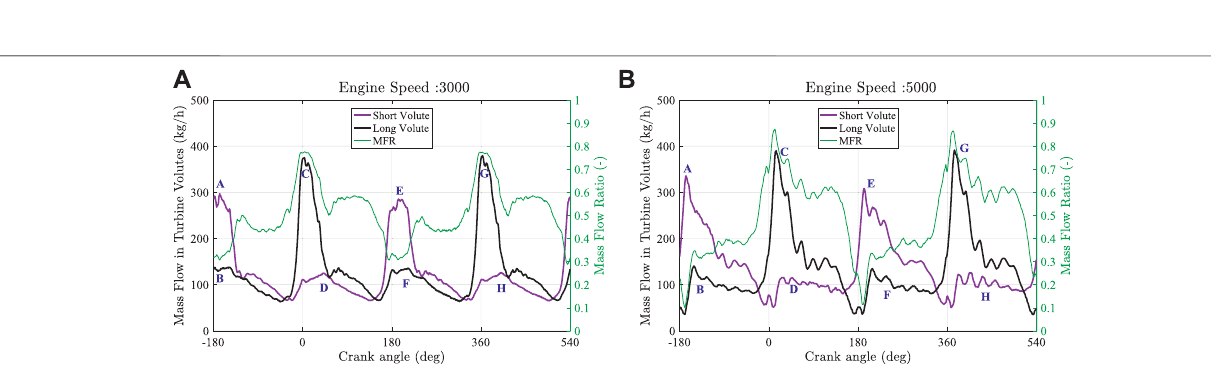
falling in each turbine branch. Every point along the instantaneous trace (shown with black and purple lines in Figure 17 ) represents the fl ow conditions of the turbine, at an instance in time. As pointed out in Figure 17 , the instantaneous traces exhibits a smaller, secondary loop (pointed with B and F in long volute; D and H in short volute) at the base of the trace where the expansion ratio is low in the idle period of a pulse ( Figure 16 ).